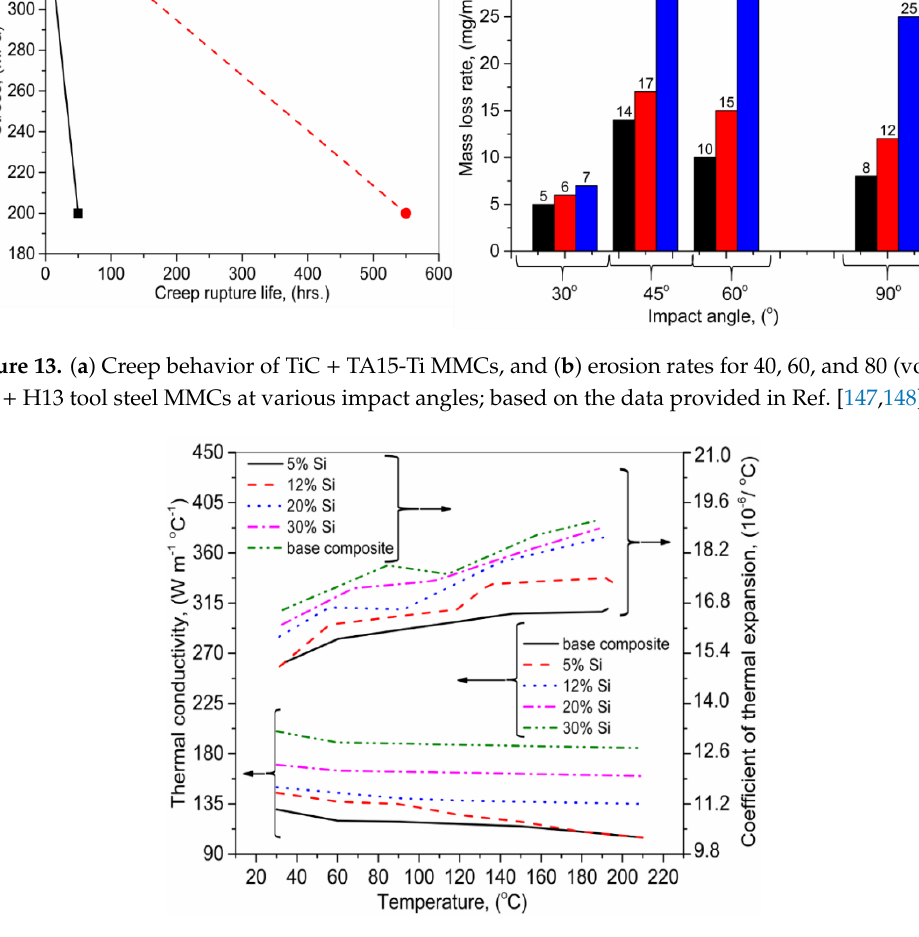
Figure 14. The relation between temperature and various fractions of Si on thermal conductivity and thermal expansion coefficient; based on the data provided in Ref. [149].